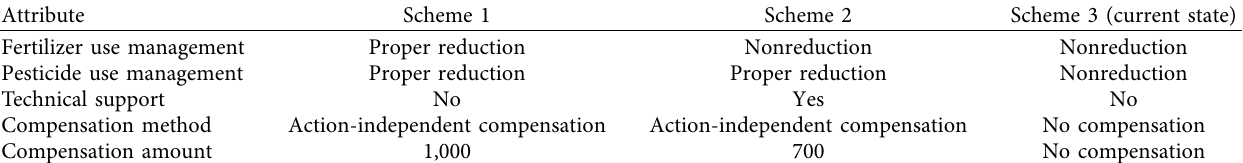
Table 3: A choice set.